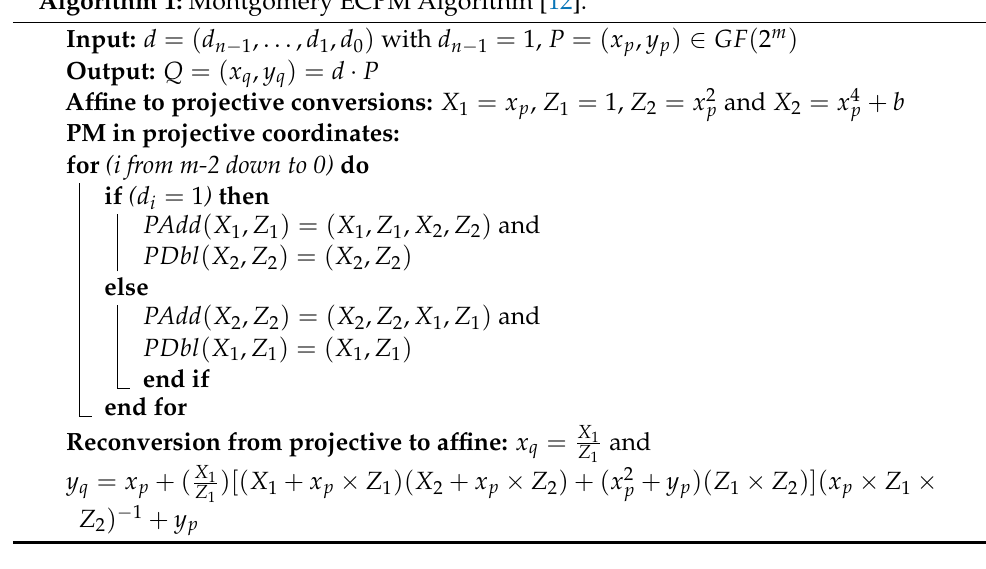
Algorithm 1: Montgomery ECPM Algorithm